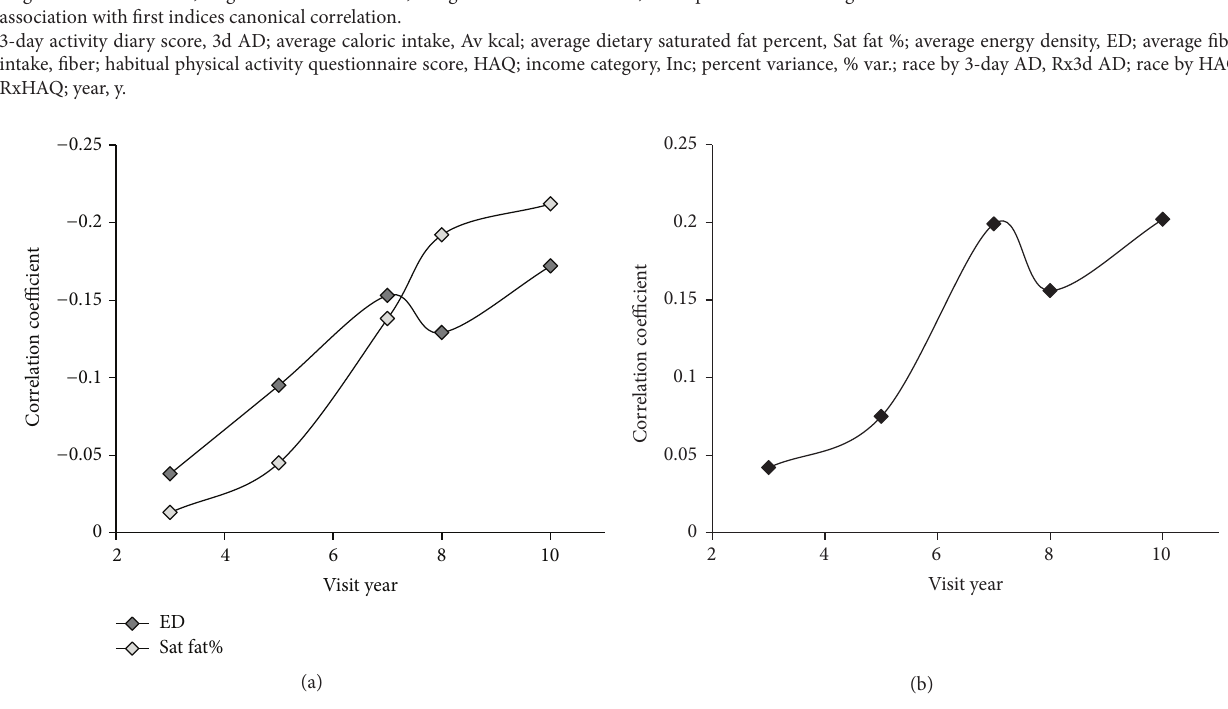
Figure 1: Spearman’s rho correlation coefficients. (a) Correlation between habitual physical activity and average energy density (ED) and dietarysaturatedfatpercent(Satfat%)byvisityear.(b)Correlationbetweenhabitualphysicalactivityandfiberintakebyvisityear.Correlation is significant (two-tailed 𝑡 , 𝑃 < 0.001 ) for years 5, 7, 8, and 10 for correlation with ED and fiber, and for years 7, 8, and 10 for correlation with Sat fat